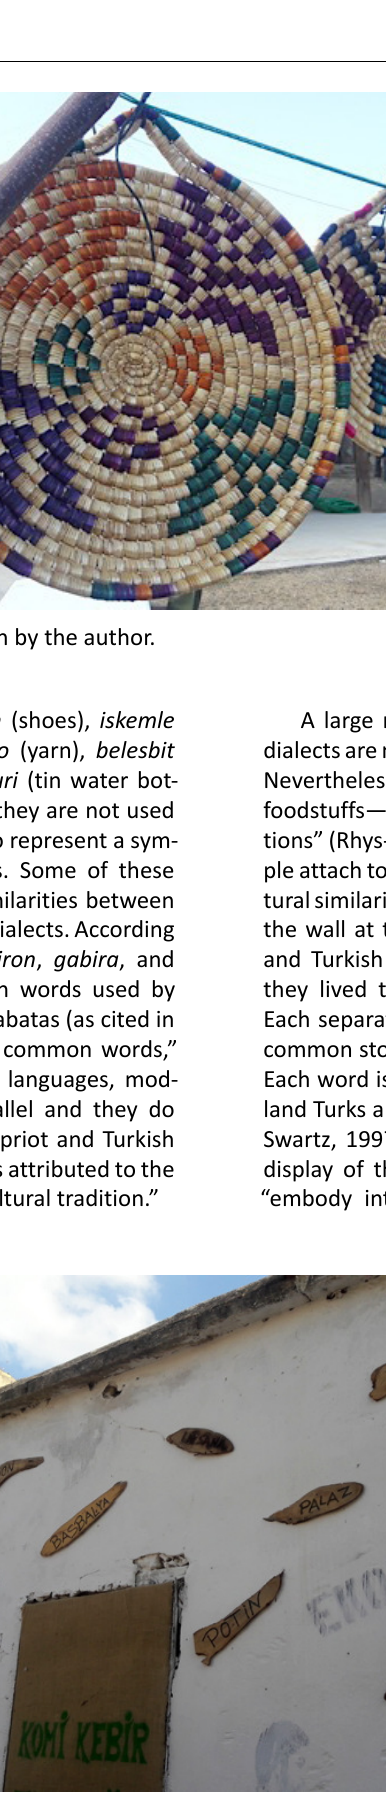
Figure 3. Words used by Turkish Cypriots in Turkish Cypriot dialect, displayed on a wall. Photograph by the author. Social Inclusion, 2021, Volume 9, Issue 4, Pages